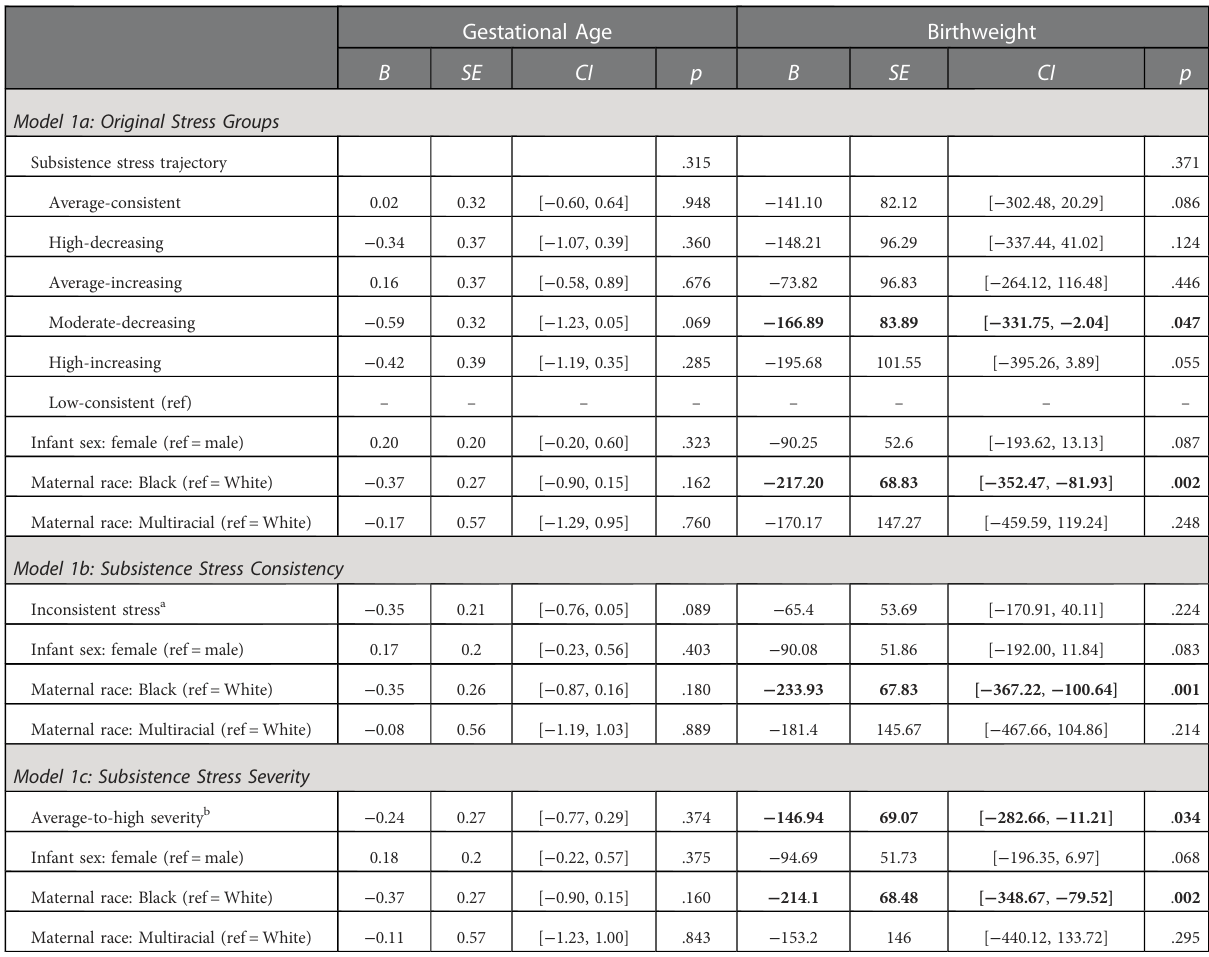
TABLE 4 Preconception exposure to subsistence stress predicting offspring birth